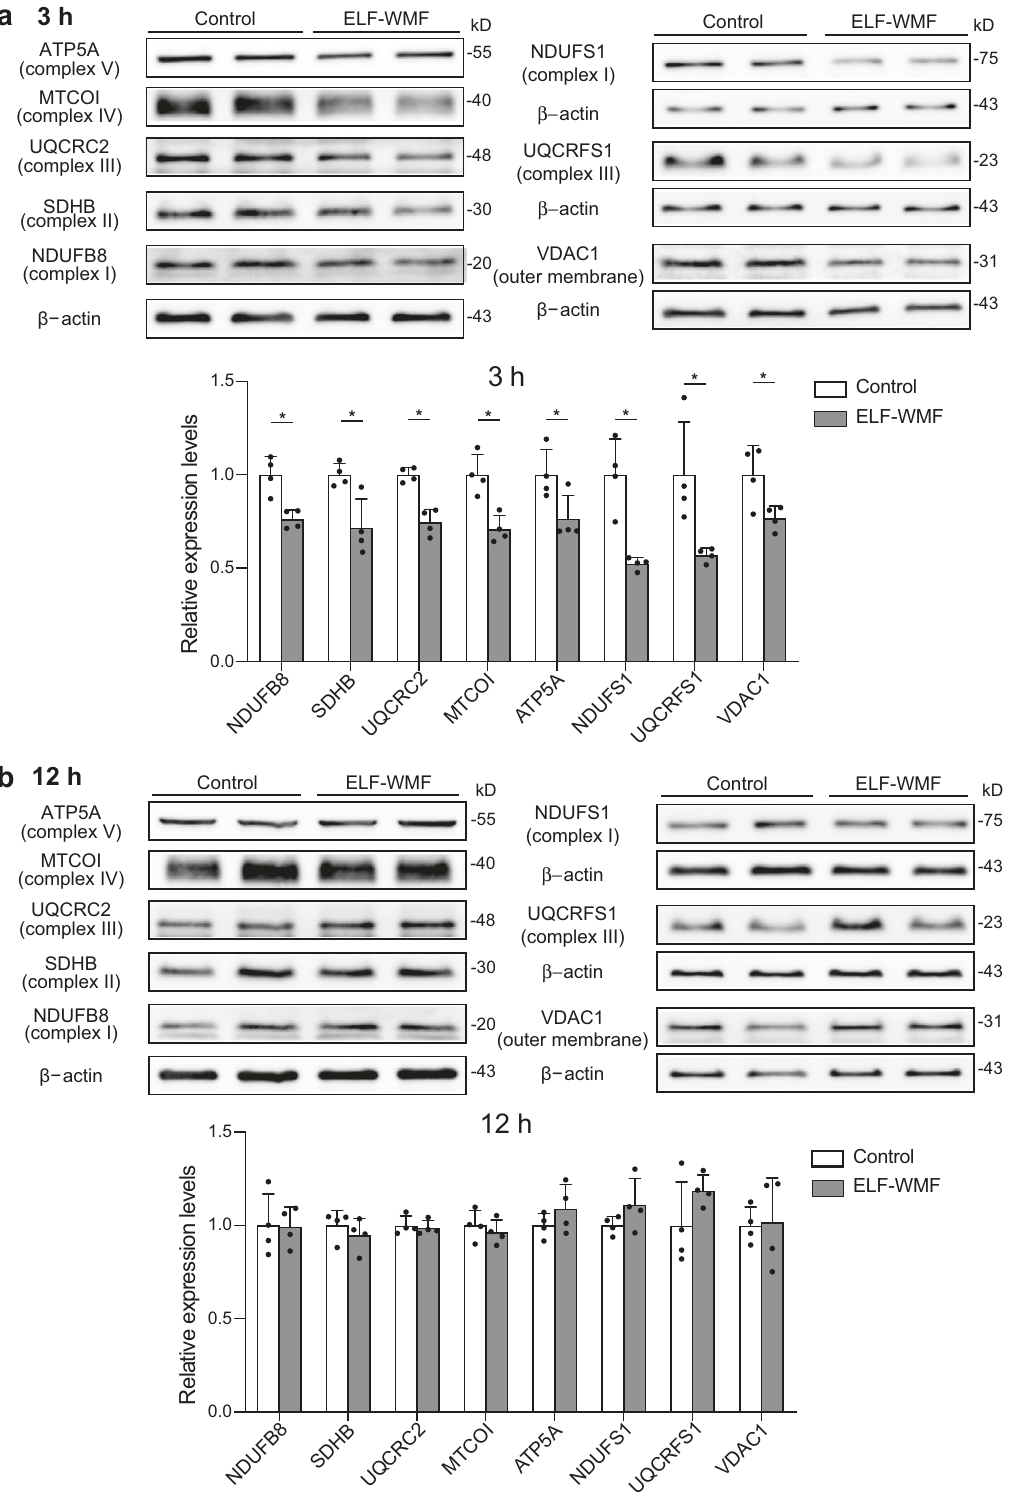
Fig. 3 Temporary downregulation of the levels of mitochondrial proteins at 3 h and recovery or slight increase at 12 h in cells exposed to Opti-ELF- WMF. Representative duplicates of Western blot analysis of mitochondrial oxidative phosphorylation proteins, as well as of a mitochondrial outer membrane protein, VDAC1, in AML12 cells are shown at 3 h ( a ) and 12 h ( b ) exposure to Opti-ELF-WMF (mean ± SD, n = 4 culture dishes each; * q < 0.05, and ** q < 0.01 by multiple Student ’ s t -tests). See also Fig.